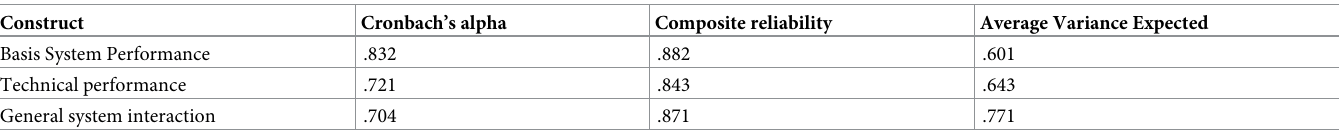
Table 3. Measures of internal consistency for the category ‘Basic System Performance’: Cronbach’s alpha, composite reliability and the Average Variance